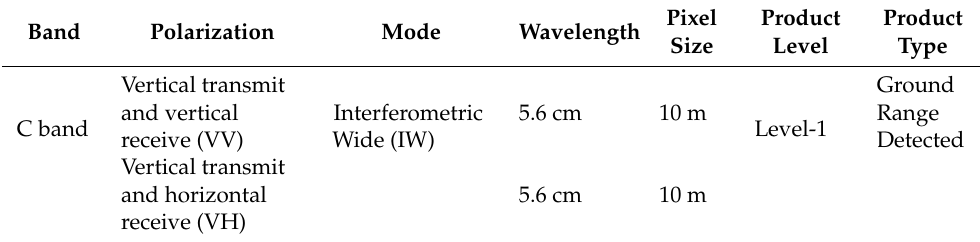
Table 2. Characteristics of Sentinel-1